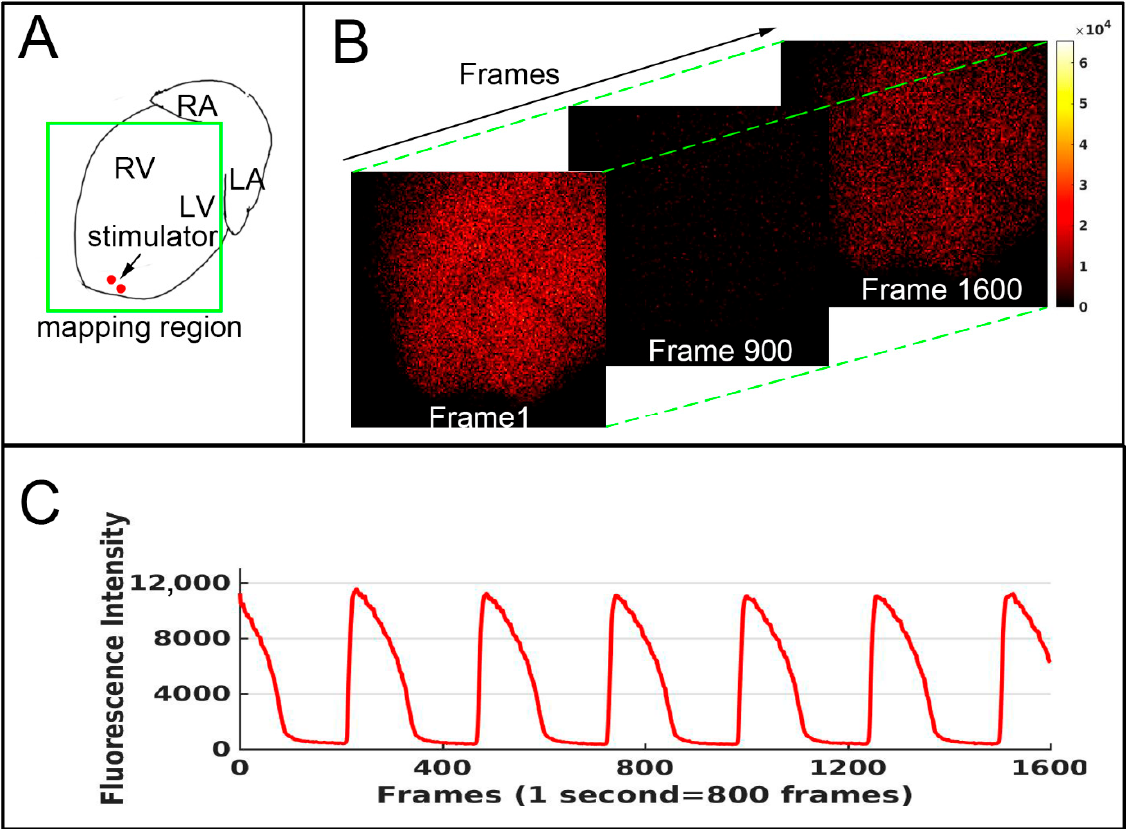
Figure 1. ( A ) schematic diagram showing the mapping region and the location of the pacing stimu- lator. ( B ) Consecutive mapping of the Ca 2+ fluorescence signal. The sampling frequency was 800 frames/second. For clarity, only the 1st, 900th and 1600th frames are displayed. ( C ) Plot of the averaged fluorescence intensity of each frame in ( B ) ( Y axis) versus the number of frames ( X